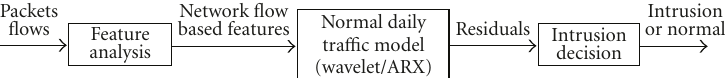
Figure 1: General architecture of the detection